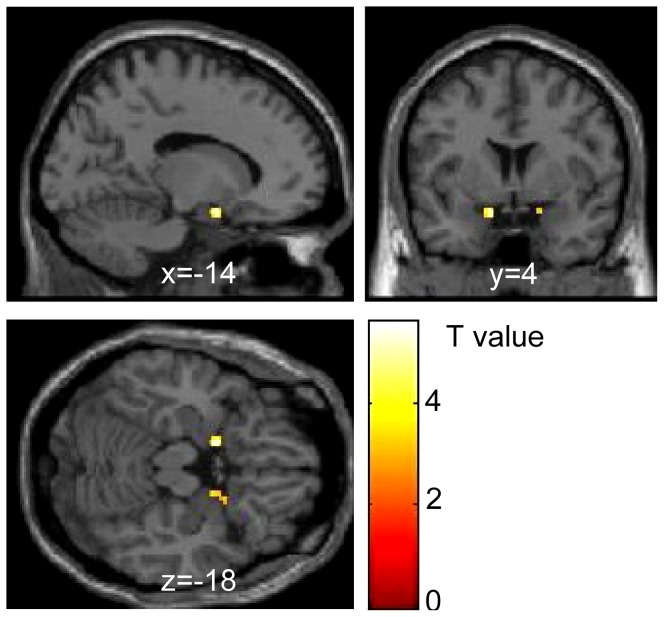
Difference in amygdala activation between the sleep control (SC) and sleep debt (SD) sessions.The map shows significantly greater activation in response to fearful face stimuli in the SD than SC session. Significant differences were seen in the left amygdala, peak MNI coordinate (x, y, z) = (−14, 4, −18) mm, T(13) = 5.60, p = .0001, k = 8 contiguous voxels. A similar trend was also observed in the right amygdala, (x, y, z) = (18, 2, −18) mm, T(13) = 3.41, p = .0005, k = 7. Significant clusters are rendered on a T1 anatomical referential image displayed in neurological convention, with the left side corresponding to the left hemisphere. The clusters shown are thresholded with a lenient alpha level (p<0.01, k>5) for visualization purposes. MNI, Montreal Neurological Institute template.